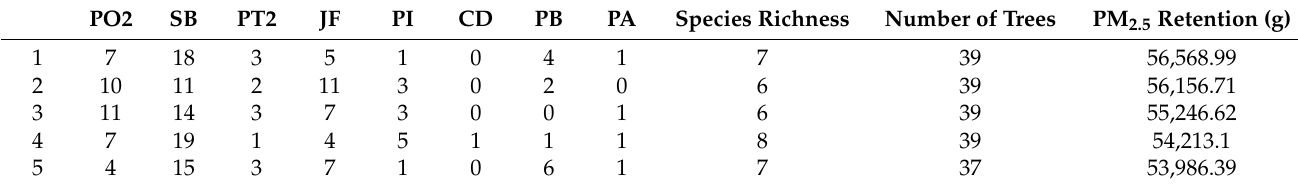
Table 5. Optimization of green space structure using 8 coniferous tree